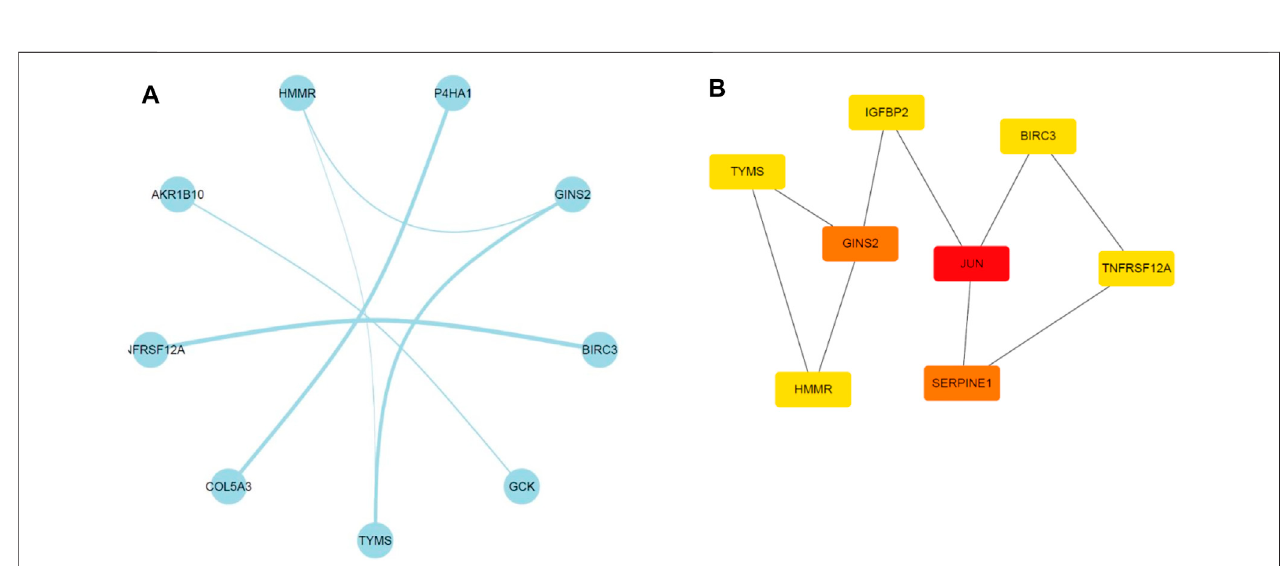
FIGURE 7 | Illustration of the PPI networks. (A) PPI network of the genes between DEG lists and co-expression modules. The nodes represent the genes. Edges indicate interaction associations between nodes. (B) Identi fi cation of the hub genes through maximal clique centrality (MCC) algorithm. Edges represent the protein- protein associations. The red nodes represent genes with a high MCC sore, and the yellow ones represent genes with a low MCC sore.